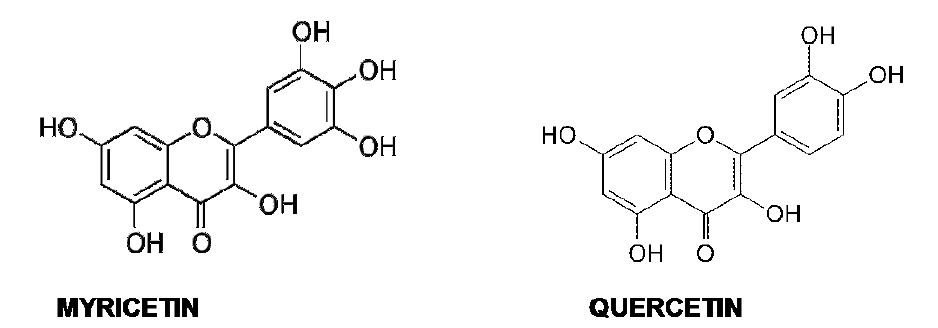
Figure 4. Myricetin and quercetin